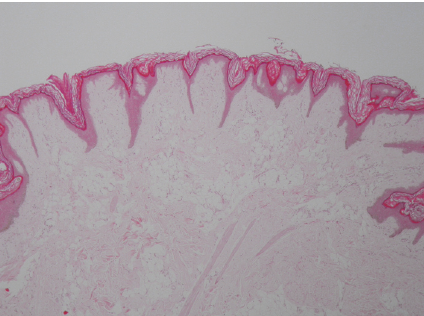
Figure 2: Histopathology showing islands of mature adipocytes in the papillary